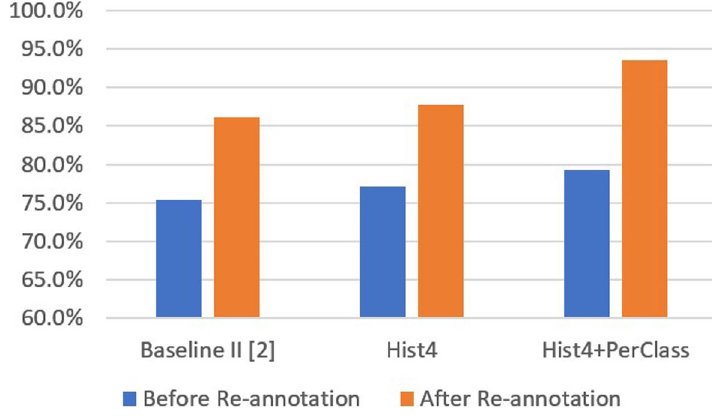
Fig. 4 The F-measure before and after the dataset re-annotation